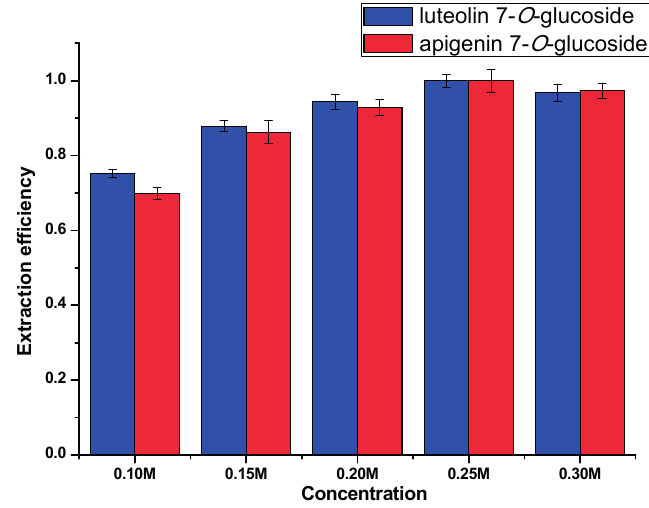
Figure 5. Extraction efficiency at different IL concentrations.